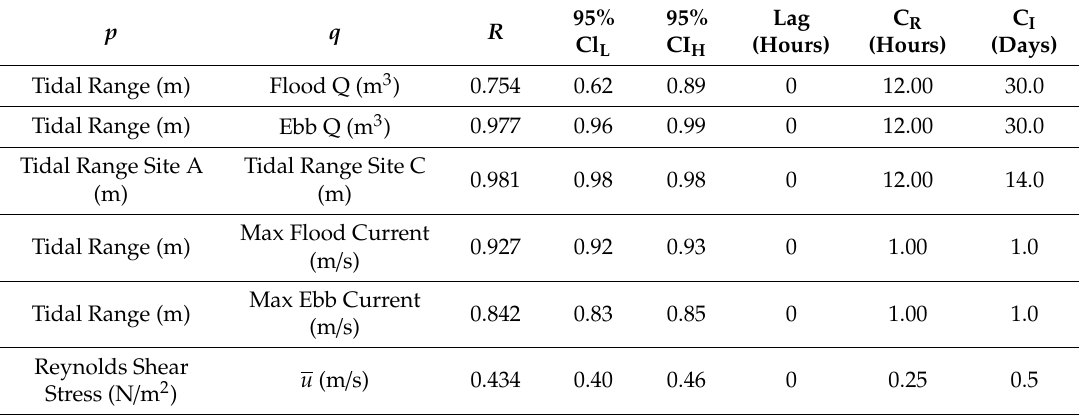
Table 2. Correlated parameters ( p and q ; Equation (4)) with the corresponding maximum correlation coe ffi cients, upper and lower 95% confidence intervals (lower: CI L ; upper: CI H ), lag time, correlation time series resolution (C R ), and correlation time interval (C I